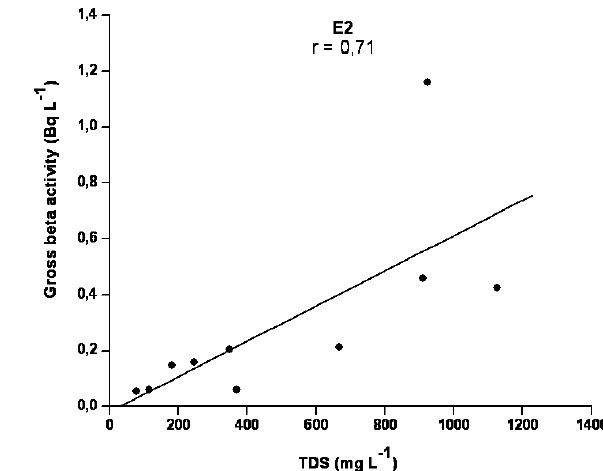
Figure 1 : Correlation between gross beta activity and the total dissolved solids using E1 method.